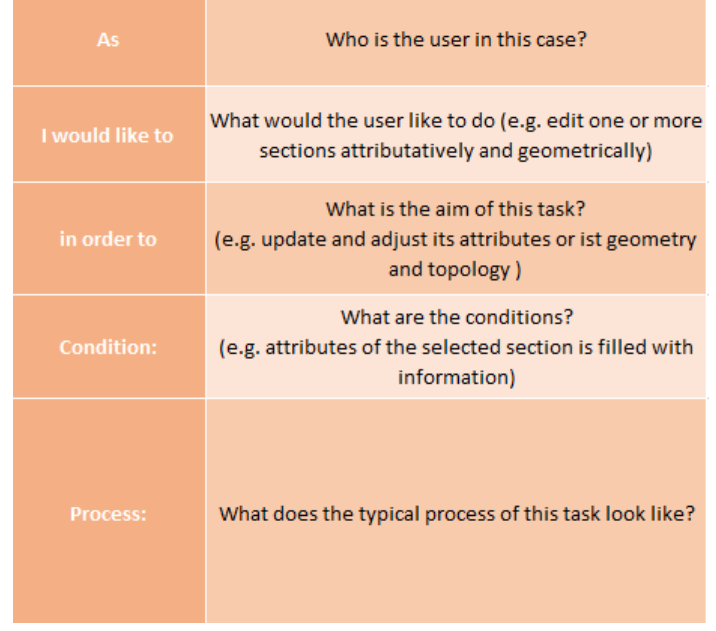
Figure 2. The structure of user stories applied in the